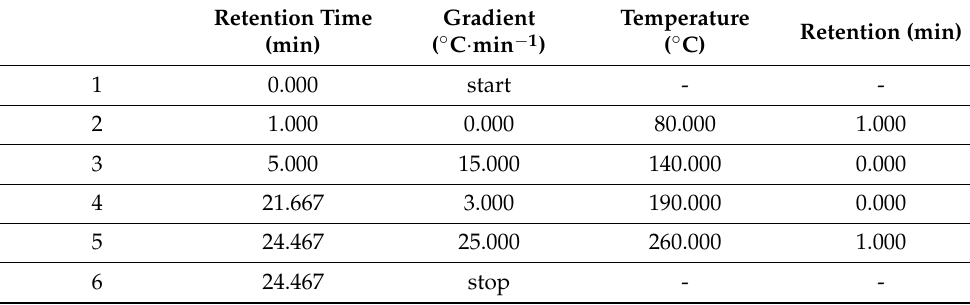
Table 4. Temperature program of GC/FID analysis of